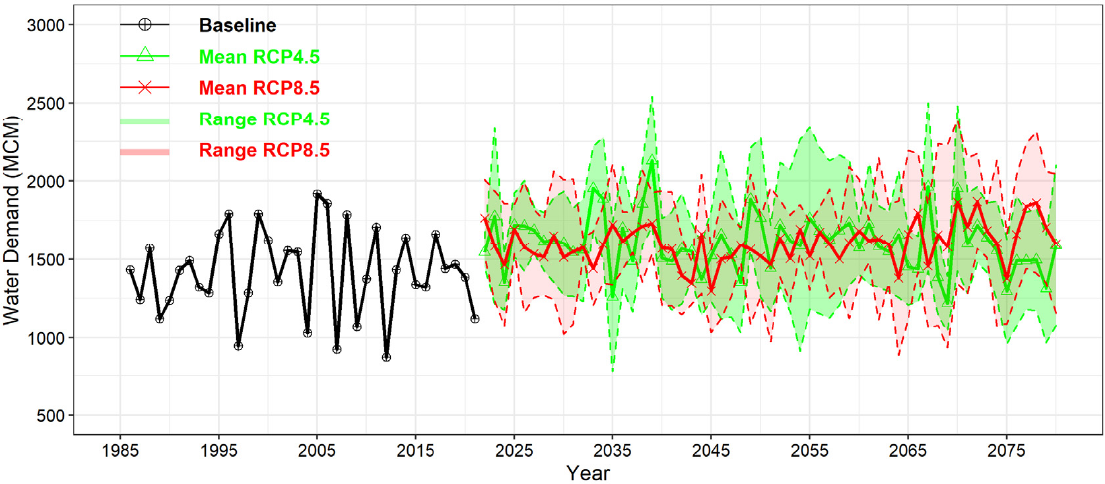
Figure 12. Annual baseline and projected agricultural water demands (MCM) in Sittaung under RCP4.5 (green) and RCP8.5 (red) scenarios.